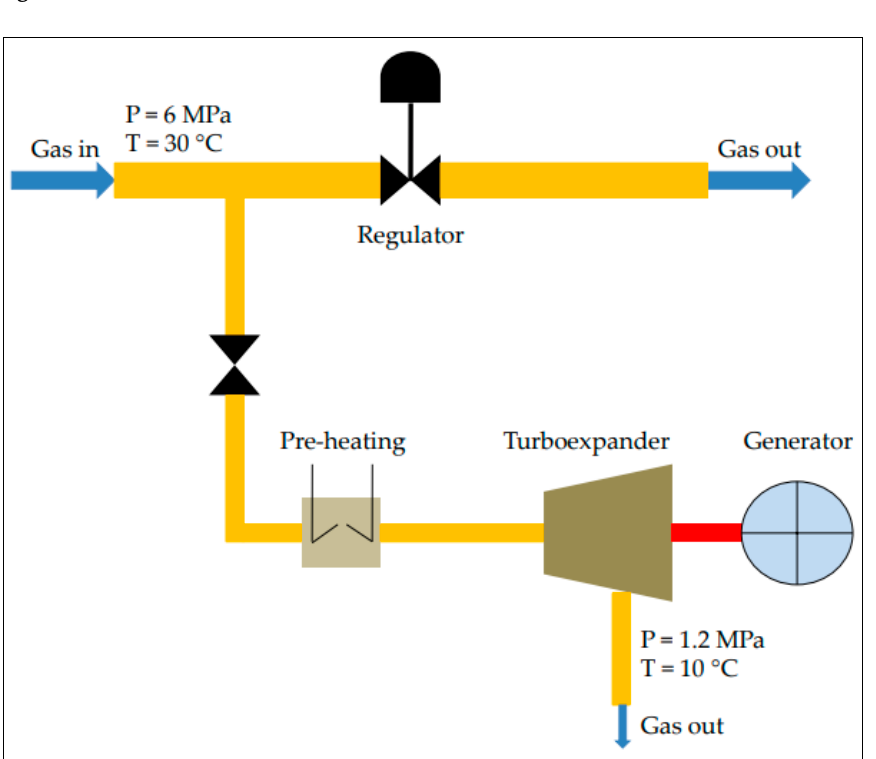
Figure 7. Scheme of the expander–generator unit.